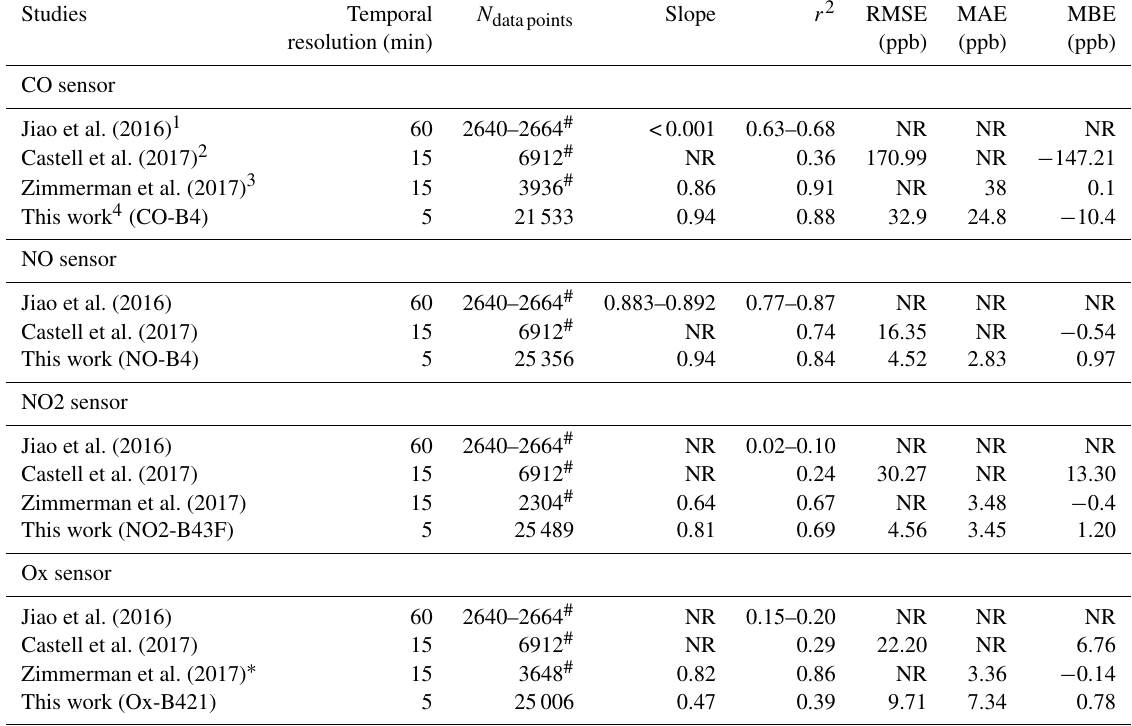
Table 4. Comparisons to published results utilizing integrated multi-pollutant systems comprised of Alphasense electrochemical sensors. Studies Temporal N